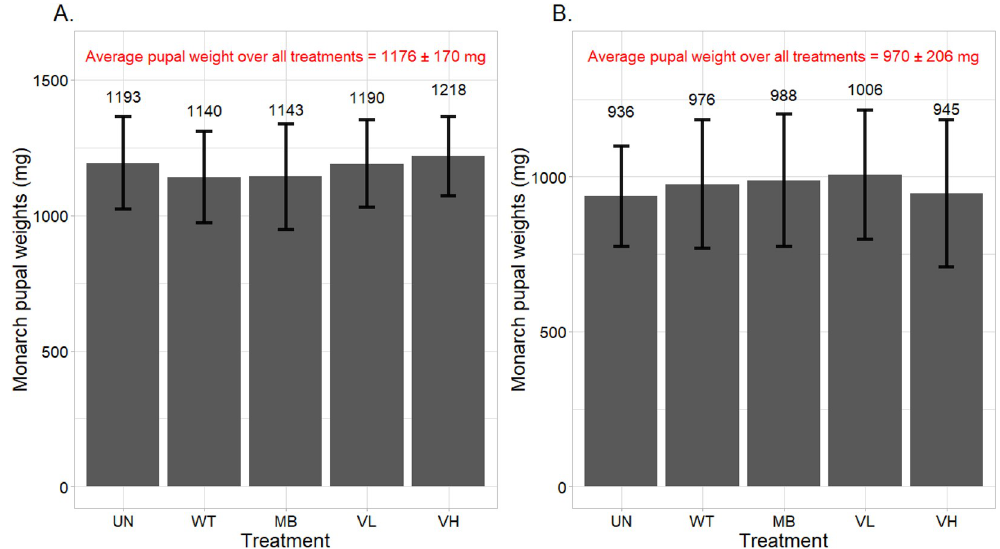
Fig 2. Average monarch pupal weight (in mg) in each treatment (data combined over all bioassay runs). Larvae were fed common (A) or tropical (B) milkweed leaves that were untreated (UN), treated with deionized water (WT), 5 mg/mL monarch-active dsRNA solution (MB), or 2.1 (VL) and 21 (VH) mg/mL Varroa-active dsRNA solutions. Bars represent the mean ± one standard deviation. A single pupa in the common milkweed water treatment was excluded from analyses.